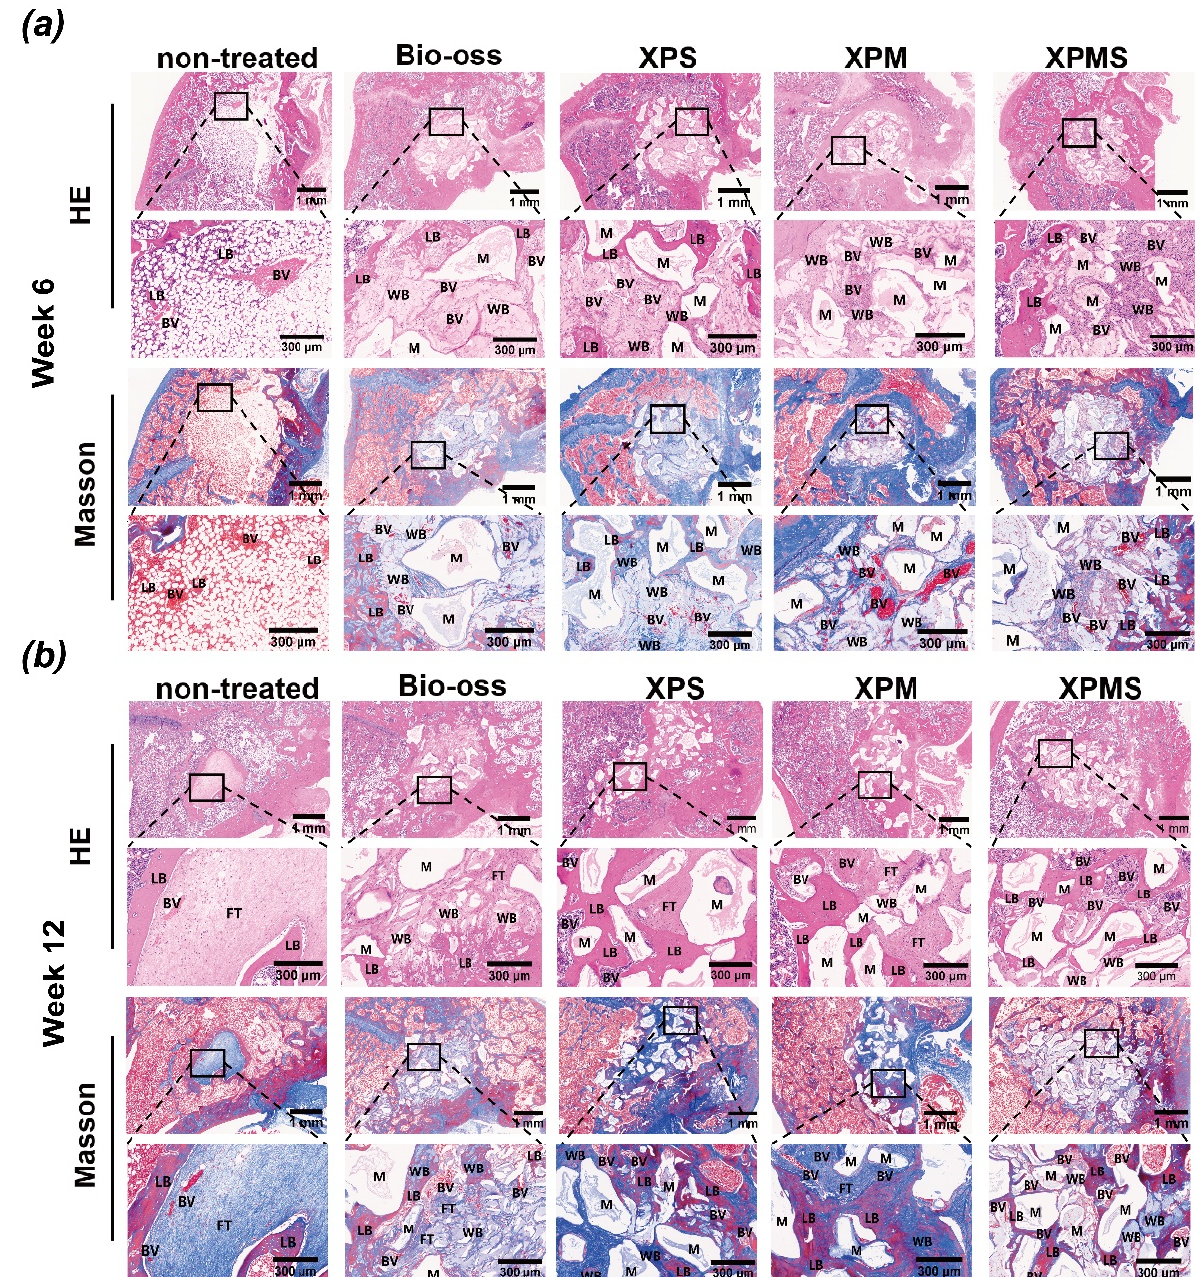
Figure 7. Histological analysis of implantation of XPMS hydrogel on femoral defect after 6 and 12 weeks. ( a ) H&E and Masson’s trichrome-stained histological sections of femoral defects after 6 and ( b ) 12 weeks of implantations; LB, lamellar bone; WB, woven bone; BV, blood vessel; FT, fibrous tissues; M, material.